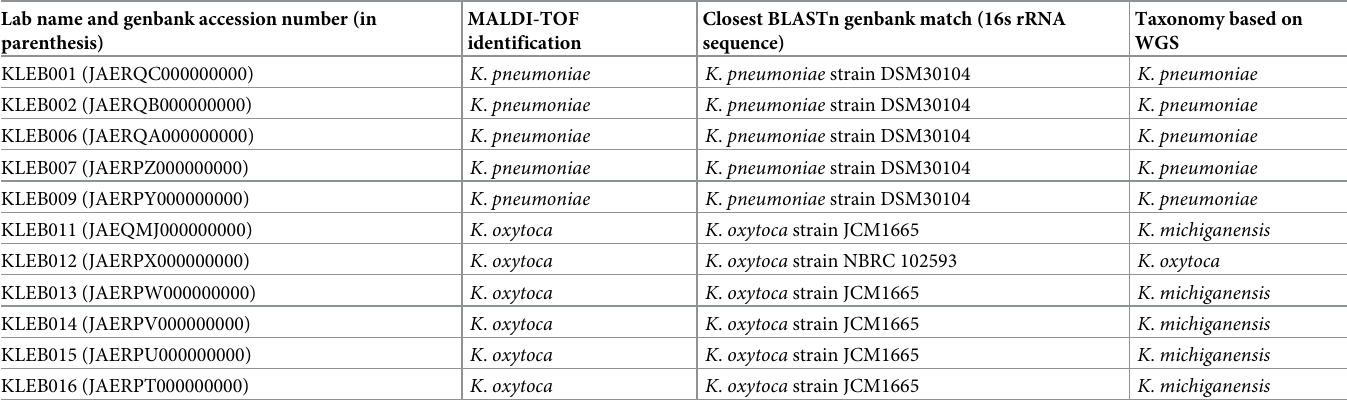
Table 1. Klebsiella spp . used for KMI8 isolation and host range studies. Lab name and genbank accession number (in